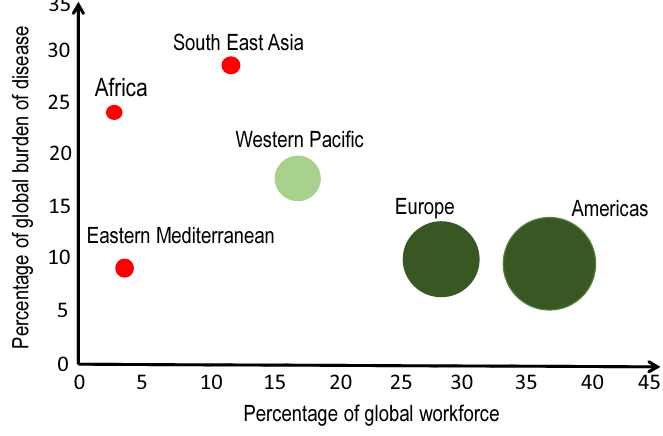
Figure 8. Distribution of health workers by level of health expenditure and burden of disease, by WHO region (adopted from: